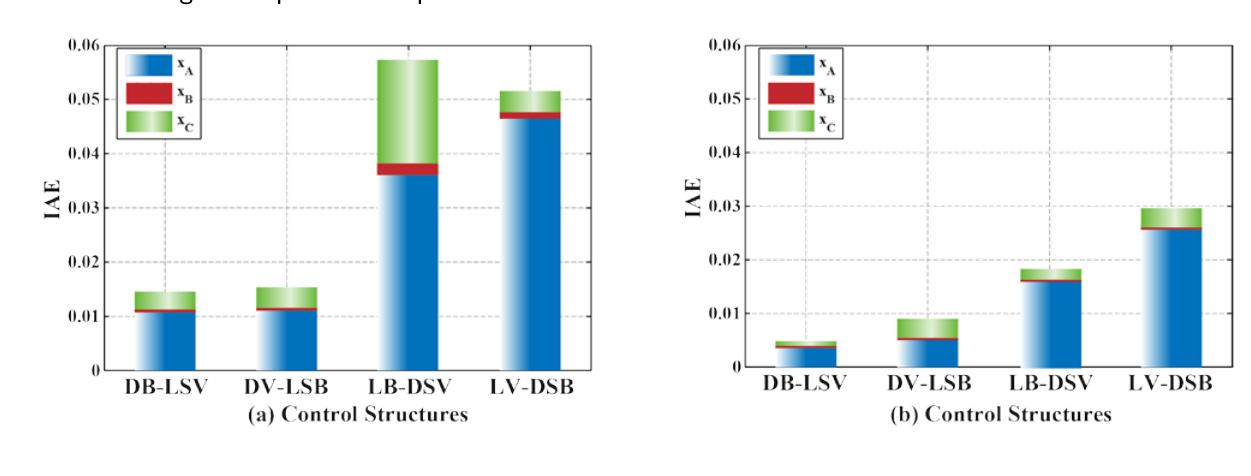
in the feed composition. 𝑥 𝐴